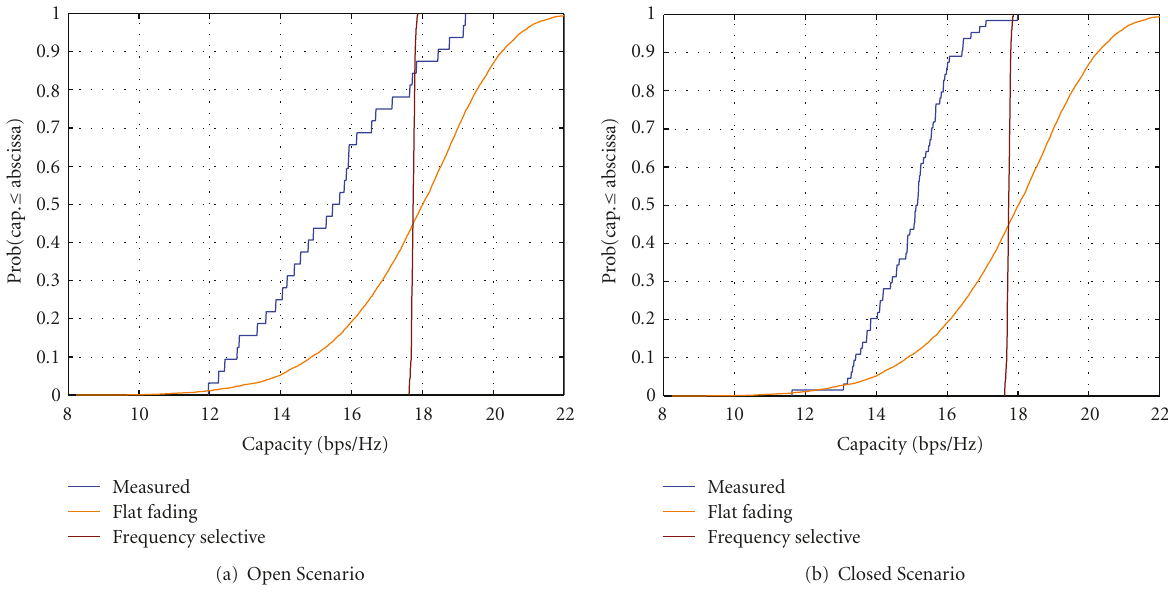
Figure 9: The MIMO channel capacity with SNR = 30 dB measured and modeled in NLOS